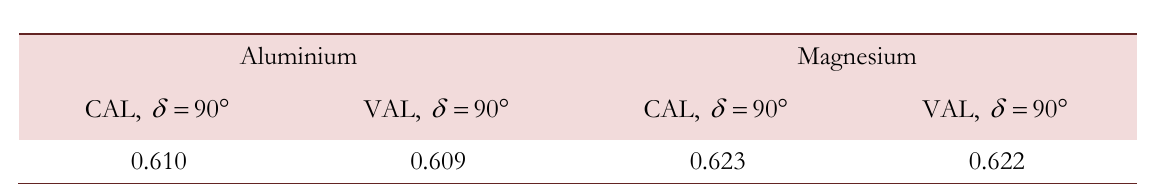
Table 2: Non-proportionality factor according to Kanazawa, generalized for spatial stress state